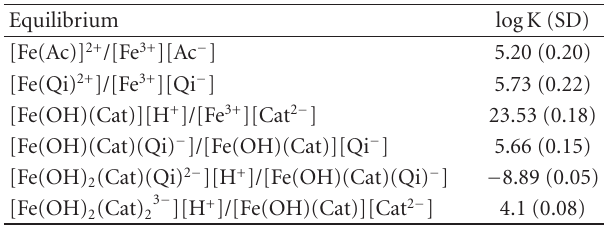
Figure 7: IR spectra of synthetic melanin in the absence and pres- ence of Fe(III) ions at di ff erent pH values. Table 3: Equilibrium constants for the interactions of natural melanin-Fe(III) ∗